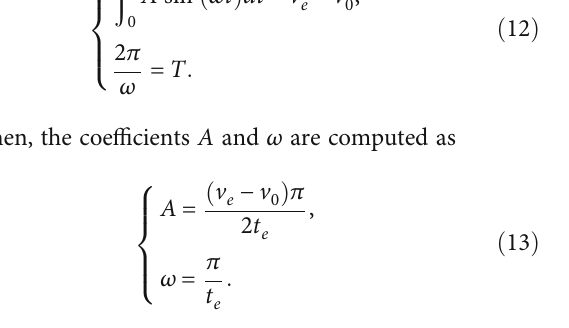
Table 1: The simulation